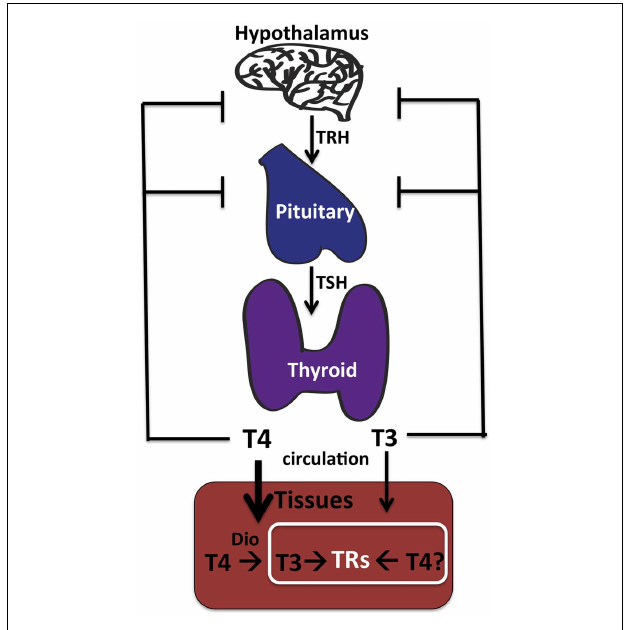
FIGURE 1 |Thyroid hormone synthesis .The thyroid gland makes bothT 4 andT 3 , althoughT 4 predominates.The hypothalamus senses lowTH in the circulation and responds by stimulating synthesis and secretion ofTRH (thyroid releasing hormone), which in turn circulates and stimulates synthesis and secretion ofTSH (thyroid stimulating hormone) by the pituitary. CirculatingTSH then increasesT 4 andT 3 production by the thyroid and ultimately in the circulation.Tissue-specific deiodinases (“DIO”) are expressed in peripheral tissues such as brain astrocytes to increase local concentrations ofT 3 from circulatingT 4 . However, we propose thatT 4 may also act directly onTRs to regulate gene transcription in neurons in the absence of deiodinase 2 conversion toT 3